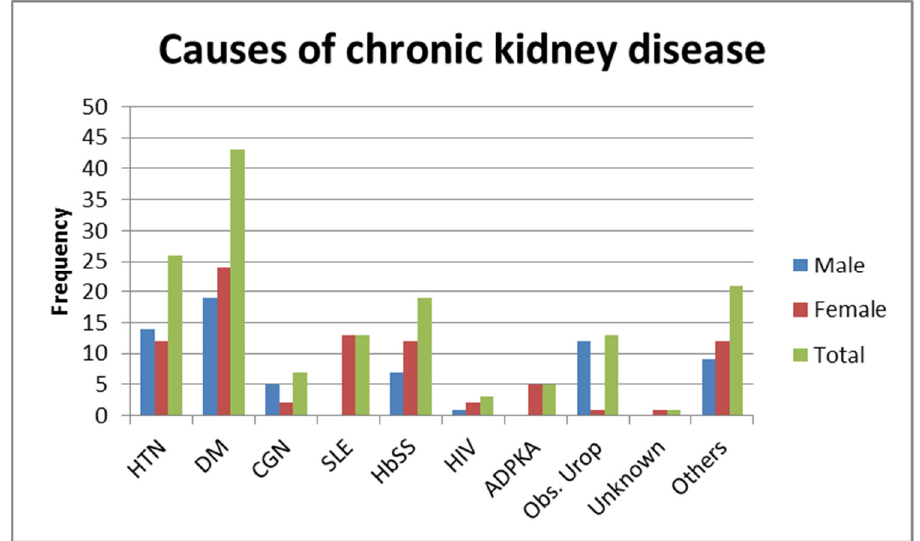
Figure 1. Causes of chronic kidney disease. HTN—hypertension; DM—diabetes mellitus; CGN—chronic glomerular nephritis; SLE—systemic lupus erythematosus; HbSS—haemoglobin SS; HIV—human immunodeficiency virus; ADPKA—autosomal dominant polycystic kidney disease; Obs. Urop.—Obstructive uropathy.